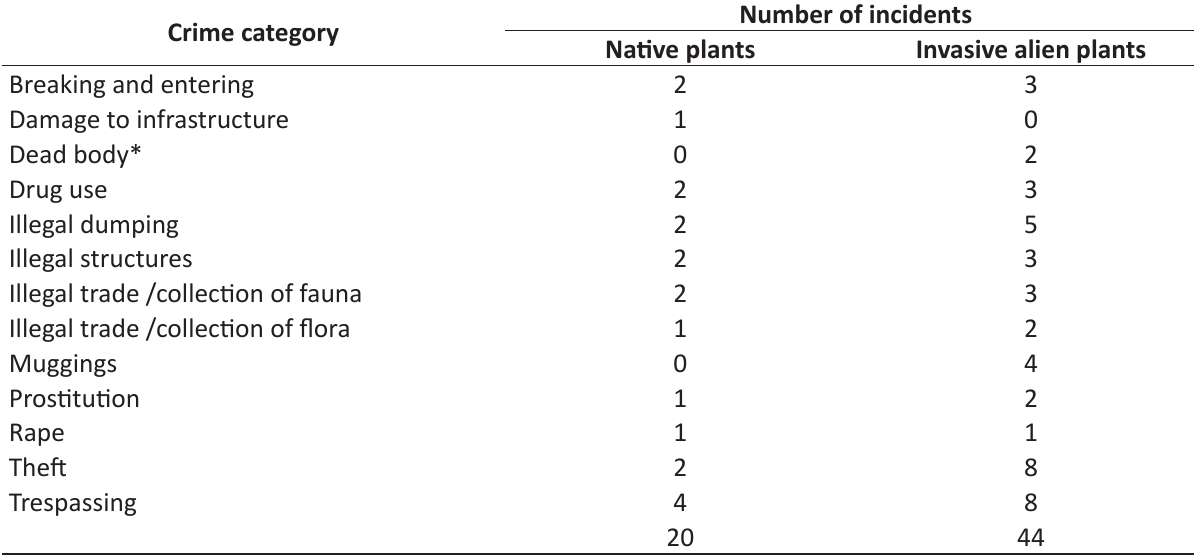
Figure 4. Conservation managers’ views on the association between criminal activity and vegetation in Cape Town, South Africa. Respondents were asked whether (a) they were aware of any safety and/or security risks associated with invasive alien and native plants, and (b) criminal activity occurs in both native and invasive vegetation, and whether the vegetation structure the ultimate factor facilitating criminal activity. Table 1. Number of vegetation-related crime incidents mentioned by respondents in the online questionnaire surveys for native plants species and invasive alien plant species (grouped according to the nature reserve crime categories from the City of Cape Town Biodiversity Branch) (t-value = -2.54; p <